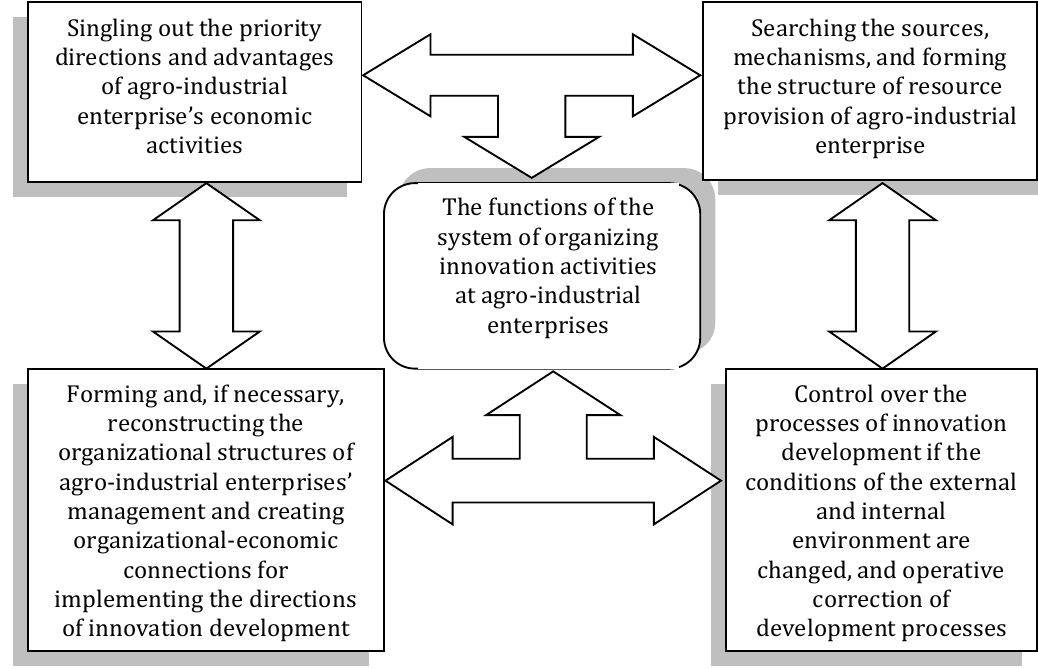
Figure 1: The main functions of the system of organizing innovation activities at agro- industrial